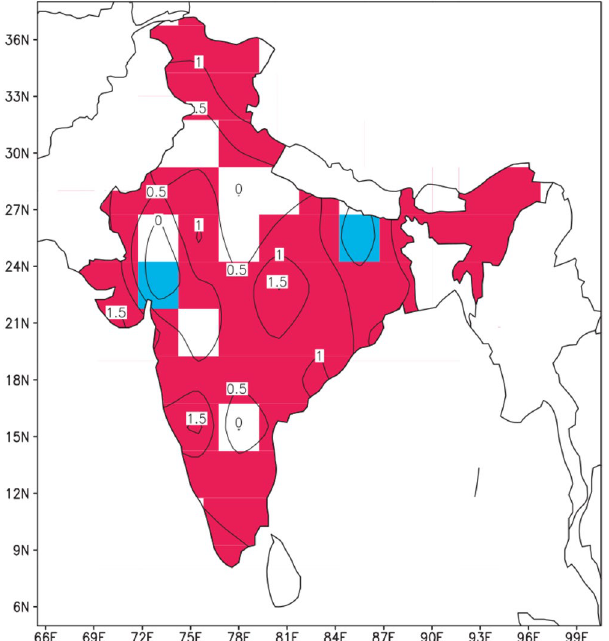
Figure 5. Annual mean temperature trends (C/100 years) over India for the period 1901–2016. Values are shown as contour lines. Trends significant at the 95% level are shaded, with positive trends shaded in red and negative trends shaded in blue. India Meteorological Department, Annual Climate Summary 2016, Pune,